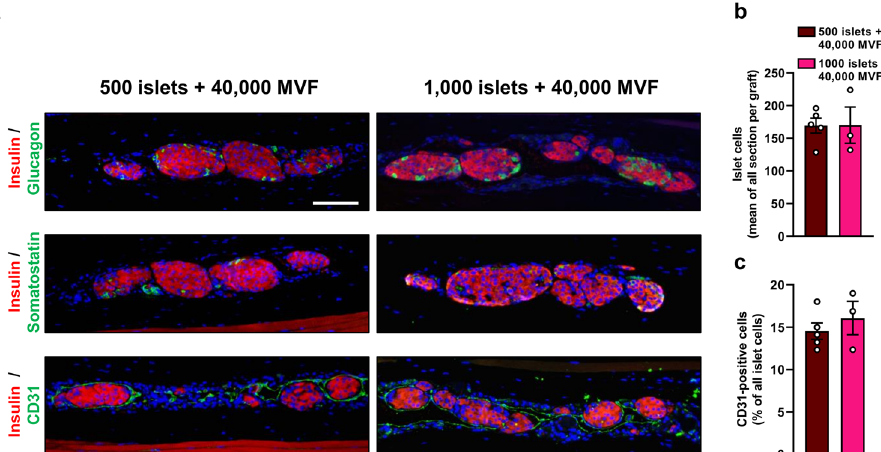
Fig. 4 Endocrine function of islets transplanted into the subcutaneous space. a Schematic illustration of the experimental setting. A diabetic phenotype was induced in mice by a single injection of STZ 8 days prior to islet transplantation. On day 0, 500 or 1000 islets with or without 40,000 MVF were subcutaneously transplanted into the diabetic mice (left image; scale bar: 2 mm). Blood glucose levels and body weights were measured from day -8 to day 108 twice a week. On day 105, the subcutaneous tissue with the grafts was harvested, and blood samples were collected (right image; scale bar: 2 mm). b Quantitative analysis of the body weight (g) of mice transplanted with 500 or 1000 islets with or without 40,000 MVF. Nondiabetic mice served as a negative control. Mean ± SEM ( n = 6 each group). c AUC (day − 8 to day 105) of the body weights from ( b ). Mean ± SEM ( n = 6 each group). d Blood glucose levels (mg/mL) of diabetic mice transplanted with 500 or 1000 islets with or without 40,000 MVF. On day 105, the grafts were removed (marked by arrow). Nondiabetic animals served as a negative control. Mean ± SEM ( n = 6 each group). e AUC (day − 8 to day 105) of the blood glucose levels from ( d ). Mean ± SEM ( n = 6 each group). One-way ANOVA followed by the Tukey post hoc test was used. + P < 0.05 vs. nondiabetic, # P < 0.05 vs . 500 islets + 40,000 MVF. f Quantitative analysis of blood glucose levels (mg/dL) according to the IPGTT of diabetic mice transplanted with 500 or 1000 islets with 40,000 MVF. Nondiabetic animals served as a negative control. Mean ± SEM ( n = 6 each group). One-way ANOVA followed by Tukey post hoc test was used. + P < 0.05 vs. nondiabetic. g AUC (day 105) of the blood glucose levels from ( f ). Mean ± SEM ( n = 6 each group). One-way ANOVA followed by Tukey post hoc test was used. + P < 0.05 vs. nondiabetic. h Plasma insulin levels (µU/mL) of diabetic mice transplanted with 500 or 1000 islets with 40,000 MVF at 15 min after glucose injection. Nondiabetic mice served as a negative control. Mean ± SEM ( n = 3 each). i Total insulin content (µU) of the removed grafts from diabetic mice transplanted with 500 or 1000 islets with 40,000 MVF. Mean ± SEM ( n = 3 each). j The proportion of